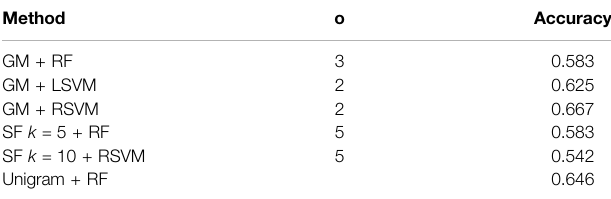
performinggraphmeasureapproaches,thetwobestSFapproachesandthebest unigram approach for comparison. There is a decrease in performance in general compared to the training set, but the best performing approach (graph measures with aRSVMclassi fi er) achieves aclassi fi cation accuracyof66.7%.